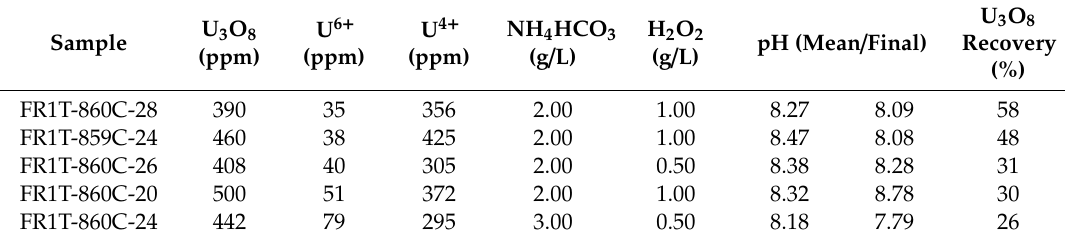
Figure 10. Trend of uranium recovery (in leaching solution) with initial U 6+ concentration (conc.) in rock samples. Table 11. Initial U 6+ concentration in rock samples and uranium recovery in alkaline media.